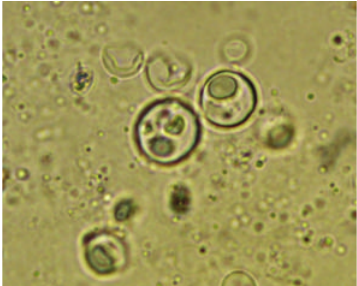
Figure 3: 100x. Direct microscopic examination with typical double-wall Paracoccidioides brasiliensis